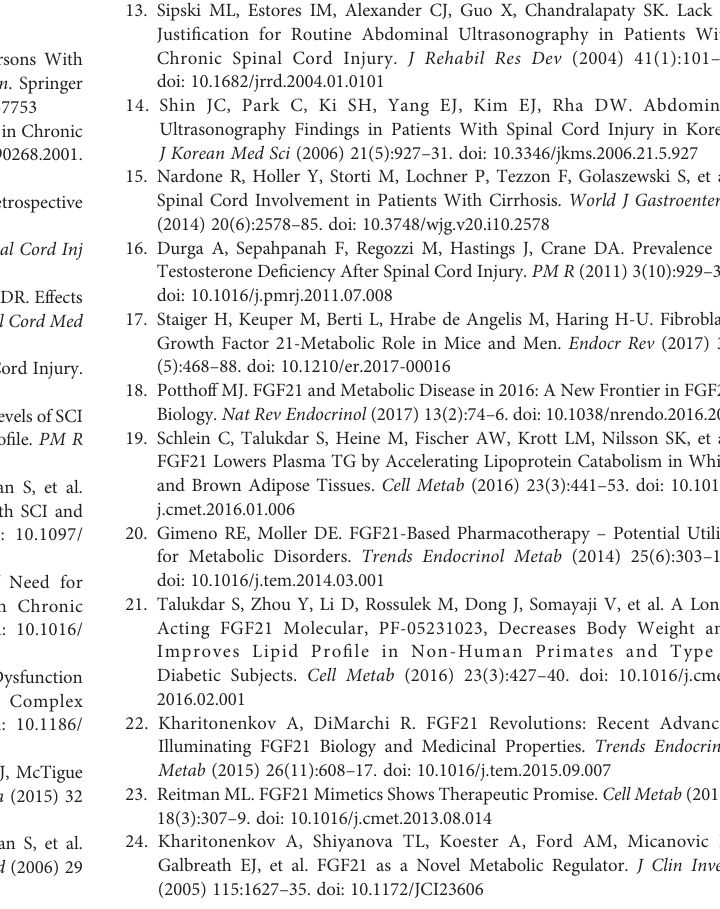
Supplementary Figure 1 | Effect of SCI and HFD on Glut4 and IRS-1 mRNA Expression in Skeletal Muscle . Mice were fed with either ConD (White Bar) or HFD (Black Bar) after surgery. Total RNA was isolated from mouse gastrocnemius and subjected to PCR analysis. (A) , IRS-1 mRNA expression; and (B) , Glut4 mRNA expression. Data shown are mean values ± SEM (n = 5). Supplementary Figure 2 | Effect of SCI and HFD on Hepatic TNF a and TNF a receptor mRNA Expression . Mice were fed with either ConD (White Bar) or HFD (Black Bar) after surgery. Total RNA was isolated from mouse liver and subjected to PCR. (A) , TNF a mRNA expression; and (B) , TNF a receptor mRNA expression. Data shown are mean values ± SEM (n = 5). Supplementary Figure 3 | Effects of SCI and HFD on lipid and fatty acid metabolism-related gene expression in the liver - Mice were fed with either ConD (White Bar) or HFD (Black Bar) after surgery. Total RNA was isolated from mouse liver and subjected to PCR. (A) , LDL receptor mRNA; (B) , Liver X receptor- a (LXR a ) mRNA; (C) , SREBP1 mRNA; (D) , UCP1 mRNA. Data shown are mean values ± SEM (n = 5). Supplementary Table 1 | Summary of Metabolic Gene Expression after SCI with or without